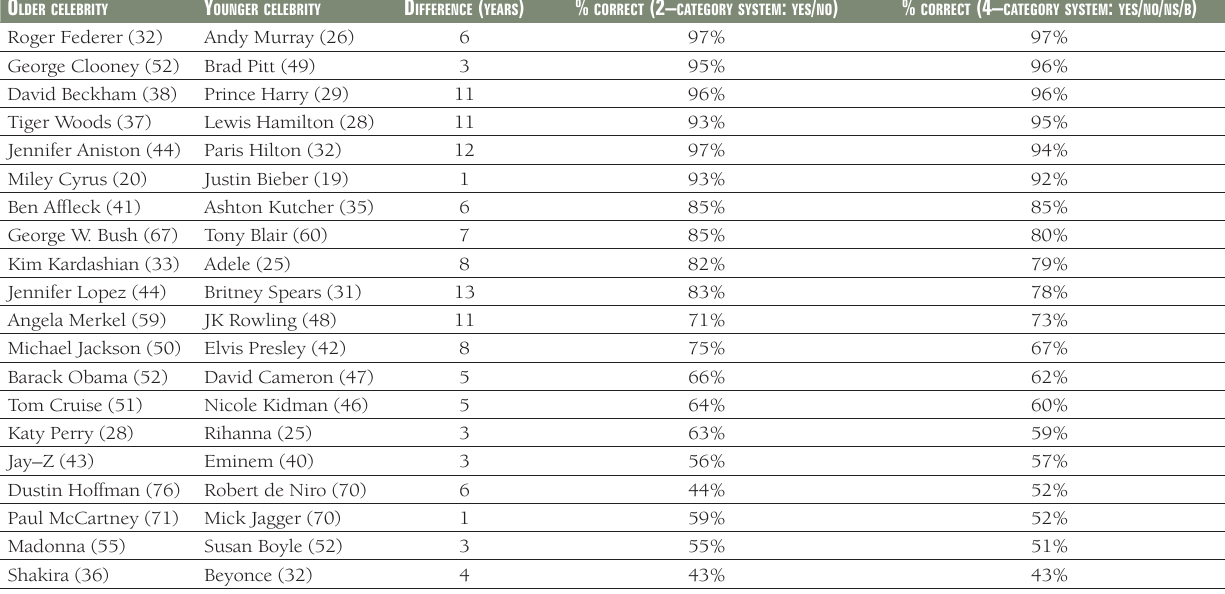
Table 7. Results of the exercise in recognizing the older of the two celebrities (N =